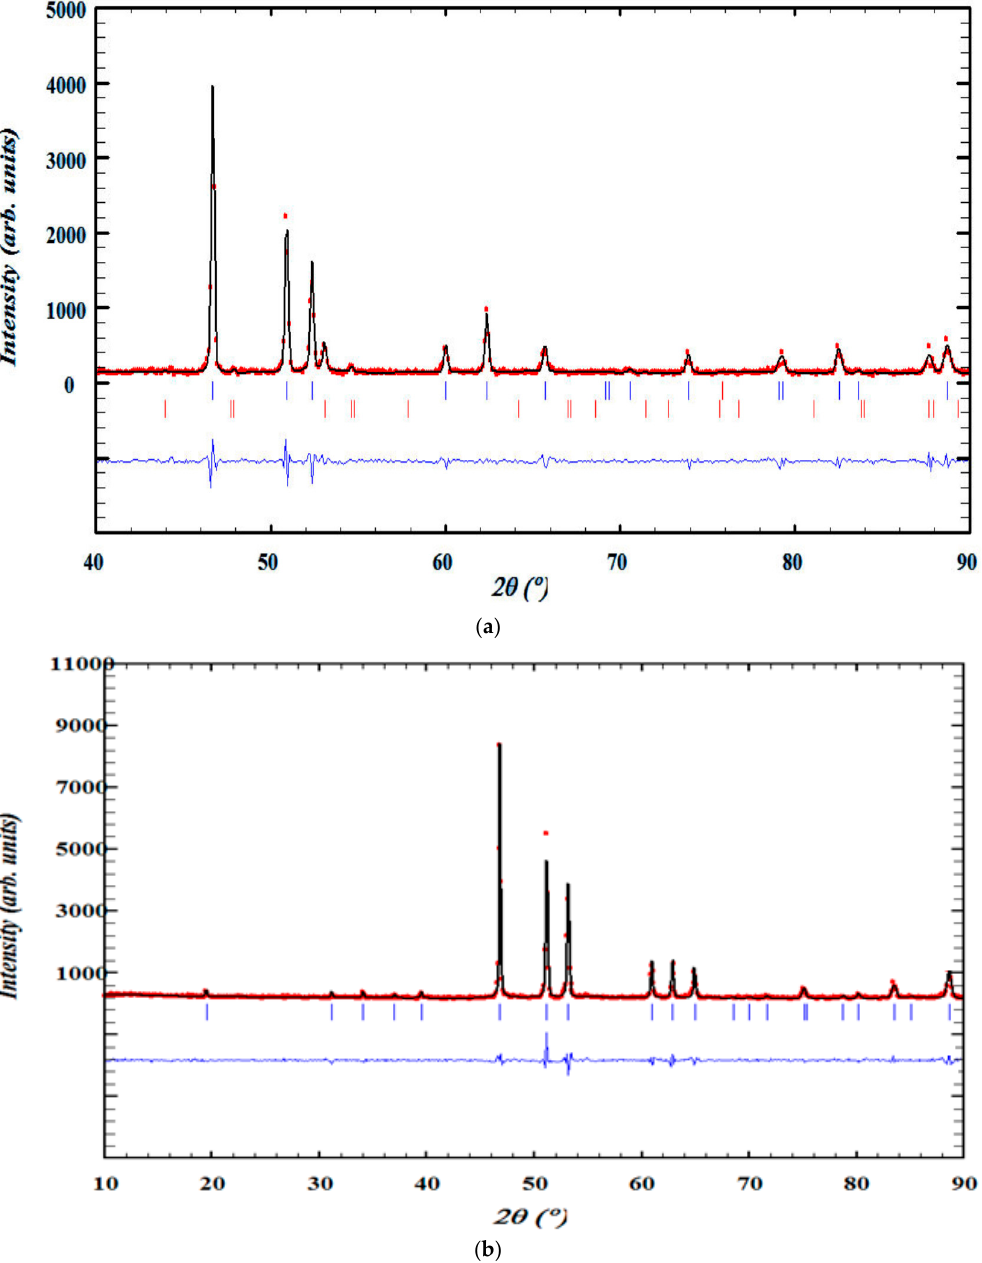
Figure 1. Examples of XRD patterns for ( a ) MnFeP 0.5 Si 0.5 , where Bragg lines are indicated by blue ticks. A small % of silicide impurity MnFe é Si is indicated by red ticks. ( b ) Mn 0.6 Fe 1.4 P 0.6 Si 0.4 > 99% pure. Table 1. Structural parameters of MnFeP 0.5 Si 0.5 ( I ) and Mn 0.6 Fe 1.4 P 0.6 Si 0.4 ( II